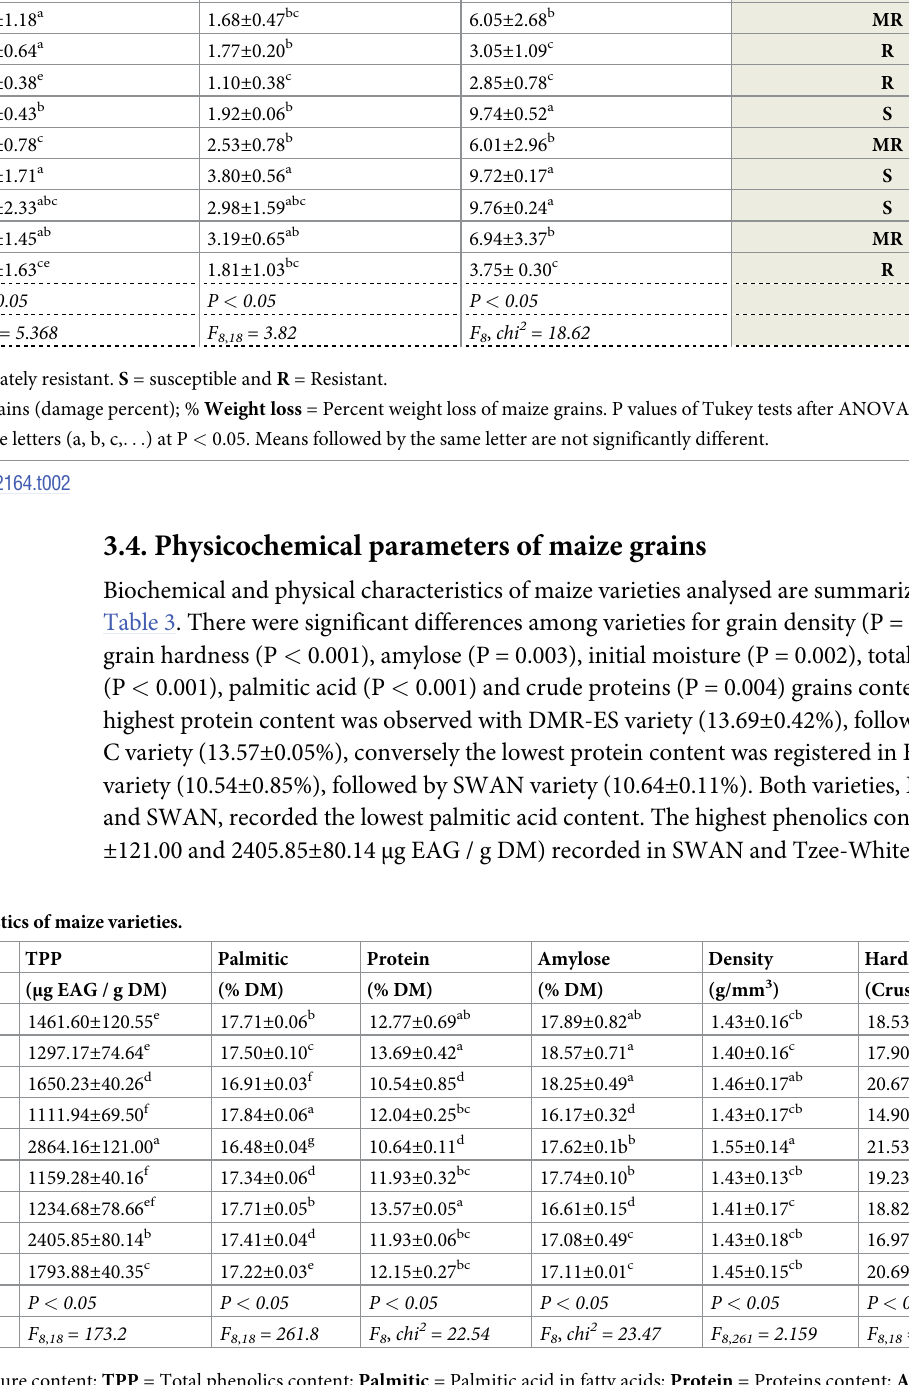
Table 2. Parameters characteristic of maize sensitivity.